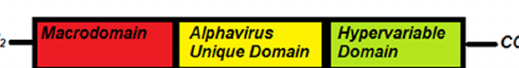
ADP ribose, as well as RNA, was shown to be